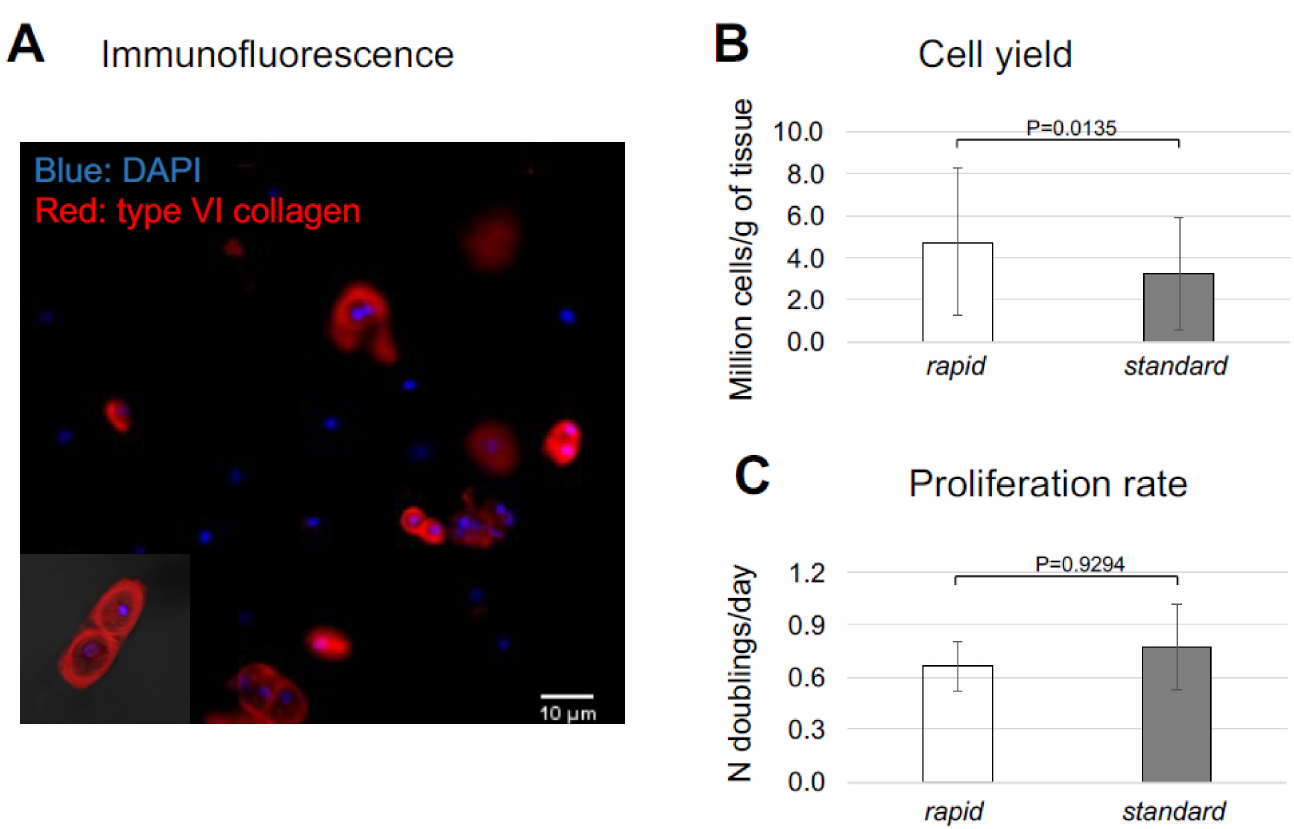
Figure 1. Properties of nasoseptal chondrocytes (NCs) generated after the rapid isolation protocol. Nasoseptal cartilage from human patients was digested 22 h with 0.15% type II collagenase ( standard protocol) or 4 h with 1.5% type II collagenase ( rapid protocol). ( A ) Immunofluorescence picture of cells isolated after the rapid isolation protocol (red: type VI collagen, blue: DAPI). ( B ) Cell yield (i.e., millions of cells/g of tissue, N = 51). ( C ) Proliferation rate (i.e., number of population doublings/day) of cells expanded in monolayer (N = 11). Values represent mean ± SD of